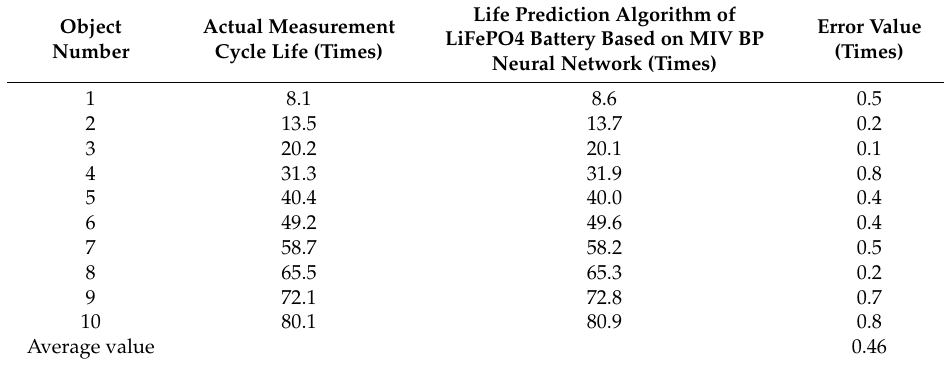
Table 7. The prediction results of the proposed algorithm. Table 8. The prediction results of the LiFePO4 battery life prediction algorithm based on the MIV BP neural